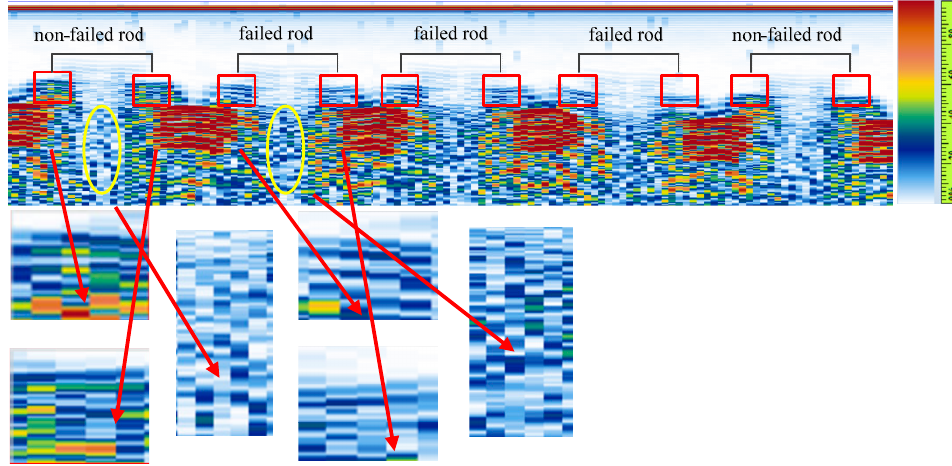
yellow ellipse of the non-failed rod is lower than that of the failed rod. The size of